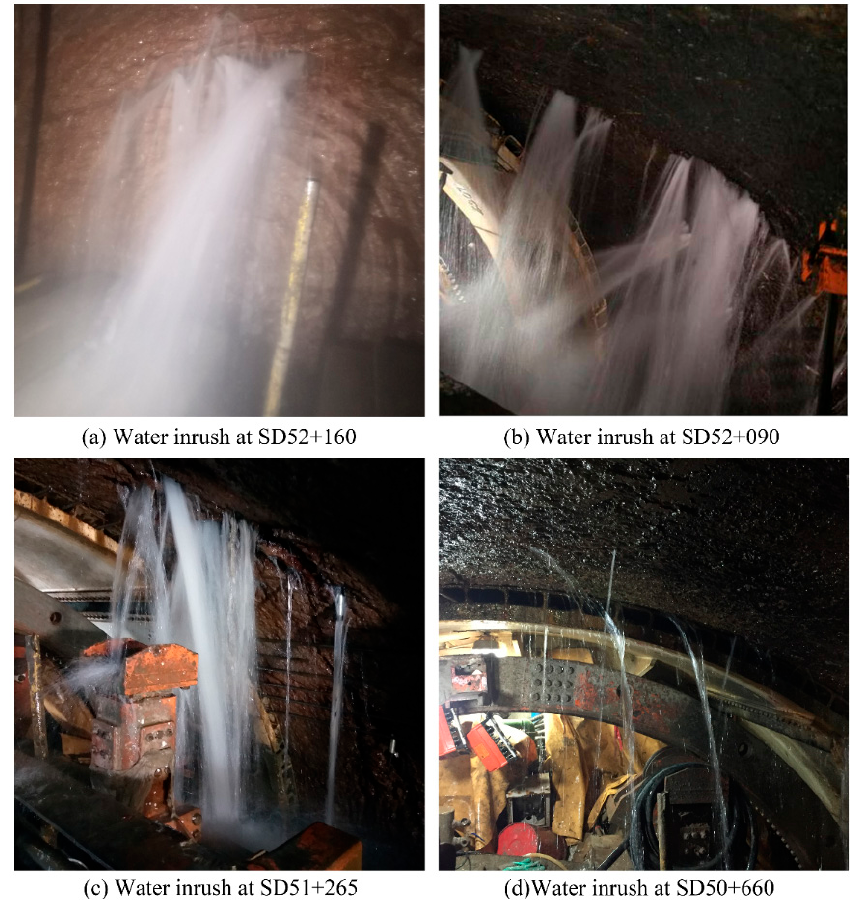
Figure 10. Practical situation of water inrush in the SS (Shuang-san) tunnel. ( a ) water inrush at + 160; ( b ) water inrush at SD52 + 090; ( c ) water inrush at SD51 + 265; ( d ) water inrush at SD50 + SD52+160; ( b ) water inrush at SD52+090; ( c ) water inrush at SD51+265; ( d ) water inrush at SD50+660. SD52